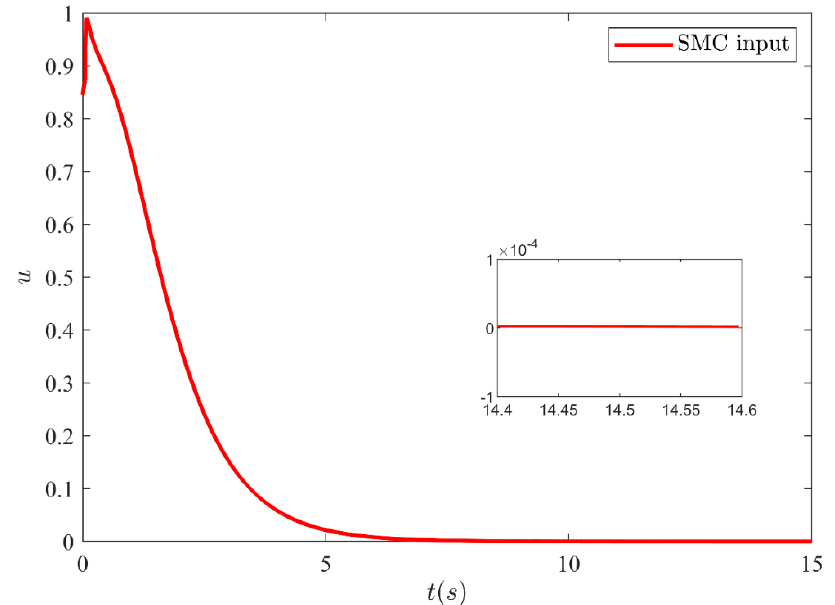
Figure 7. SMC control input with reduced chattering (using saturation function). Figure 8 illustrates the output (cid:1877) = (cid:1876) (cid:2869) stabilizing performance of the closed-loop (CL) system under SFC and OFC (with HGO) without input saturation. The output feedback is